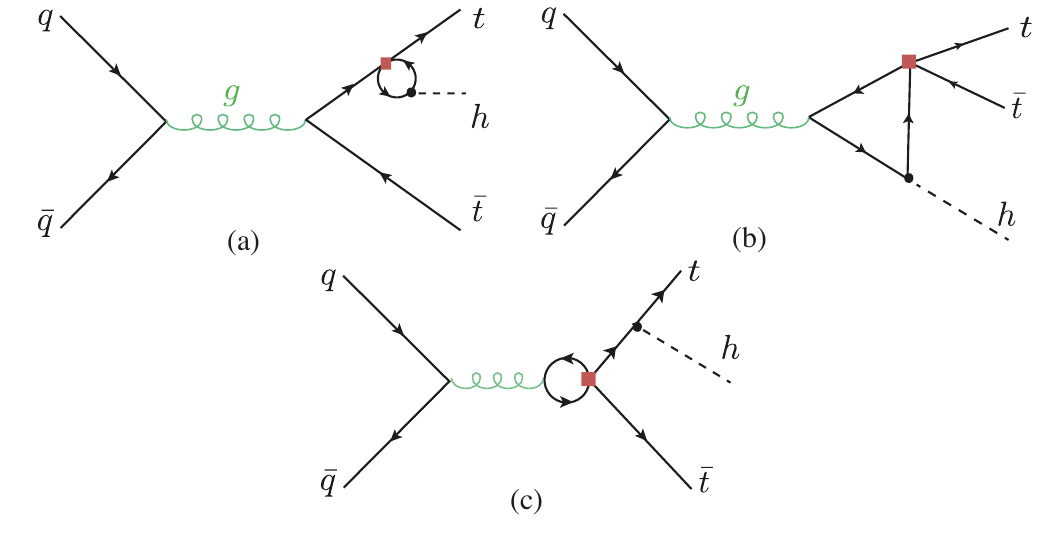
Figure 3 . Example Feynman diagrams including the four-fermion loop contributions to the gg → tth subprocess.